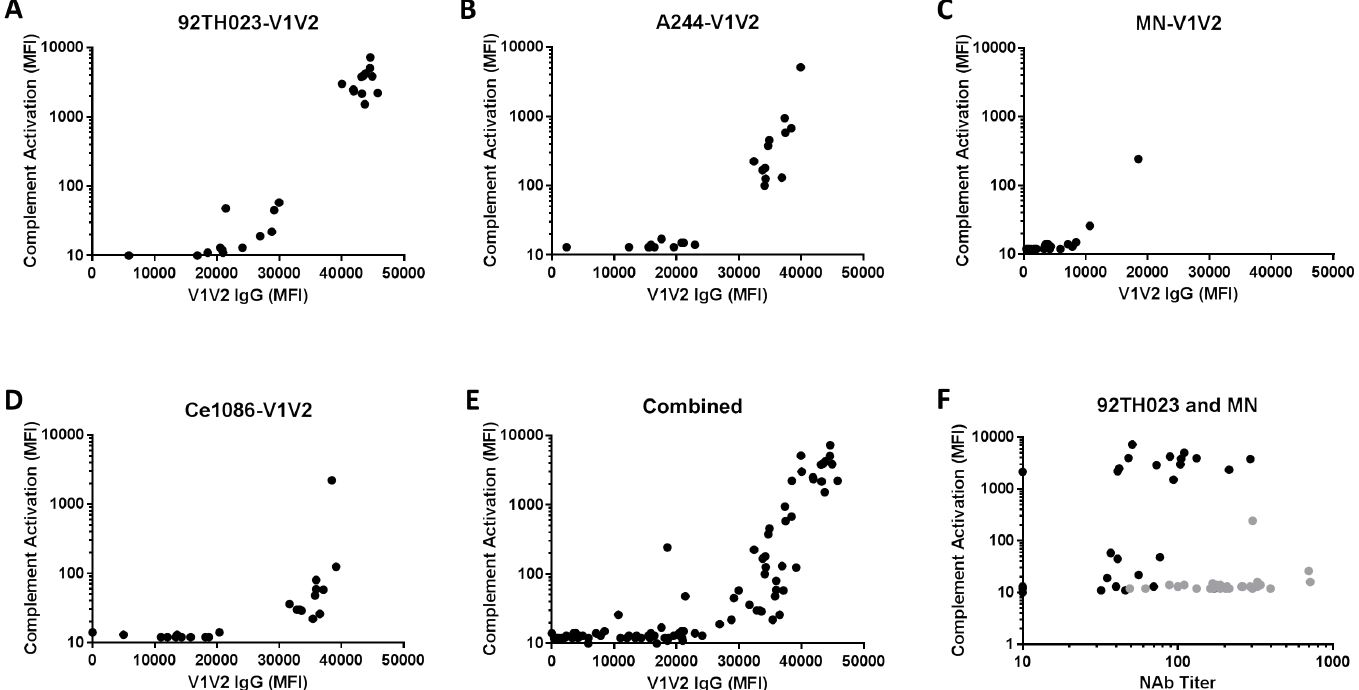
Fig 3. Complement activation requiresa critical threshold level of V1V2-specific IgG. MFI valuesfor complementactivation by RV144post-immune plasmas(visit 8) assayedin the presenceof NHS were adjustedfor non-specific activity by subtractingthe MFI of corresponding pre-immune samples(visit 1) assayedin NHS (both MFI valuesin Fig 2A). The adjustedMFI valuesare plottedagainst the correspondingMFI valuesfor V1V2-specific IgG in post-immune samples(after subtraction of non-specific IgG bindingactivity in pre-immune samples). Shownare results for individualantigens(A-D) and aggregateresults (E) poolingover the four antigensfor gp70-V1V2 of 92TH023,A244, MN and Ce1086.(F) AdjustedMFI valuesare plotted againstcorresponding neutralization titers against 92TH023(black) andMN (grey).